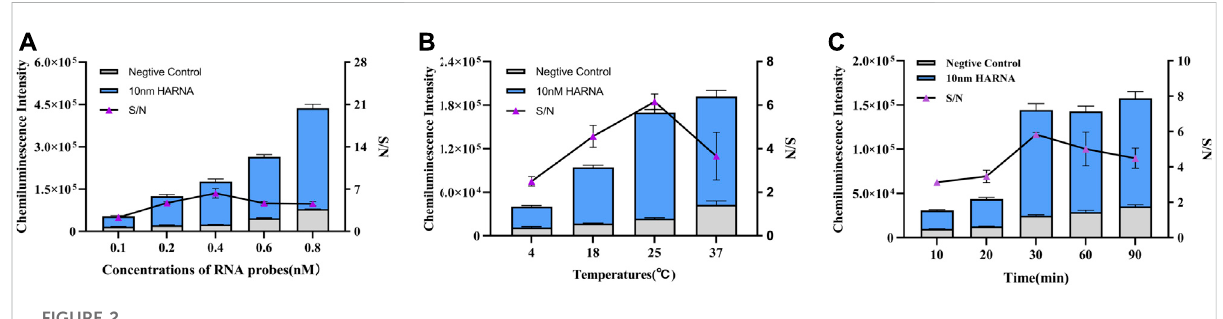
FIGURE 2 Optimization of experimental conditions. (A) Optimization of RNA probe concentration. (B) Optimization of reaction temperature. (C) Optimization of reaction time. The data are presented as mean ± S.D. of three replicate